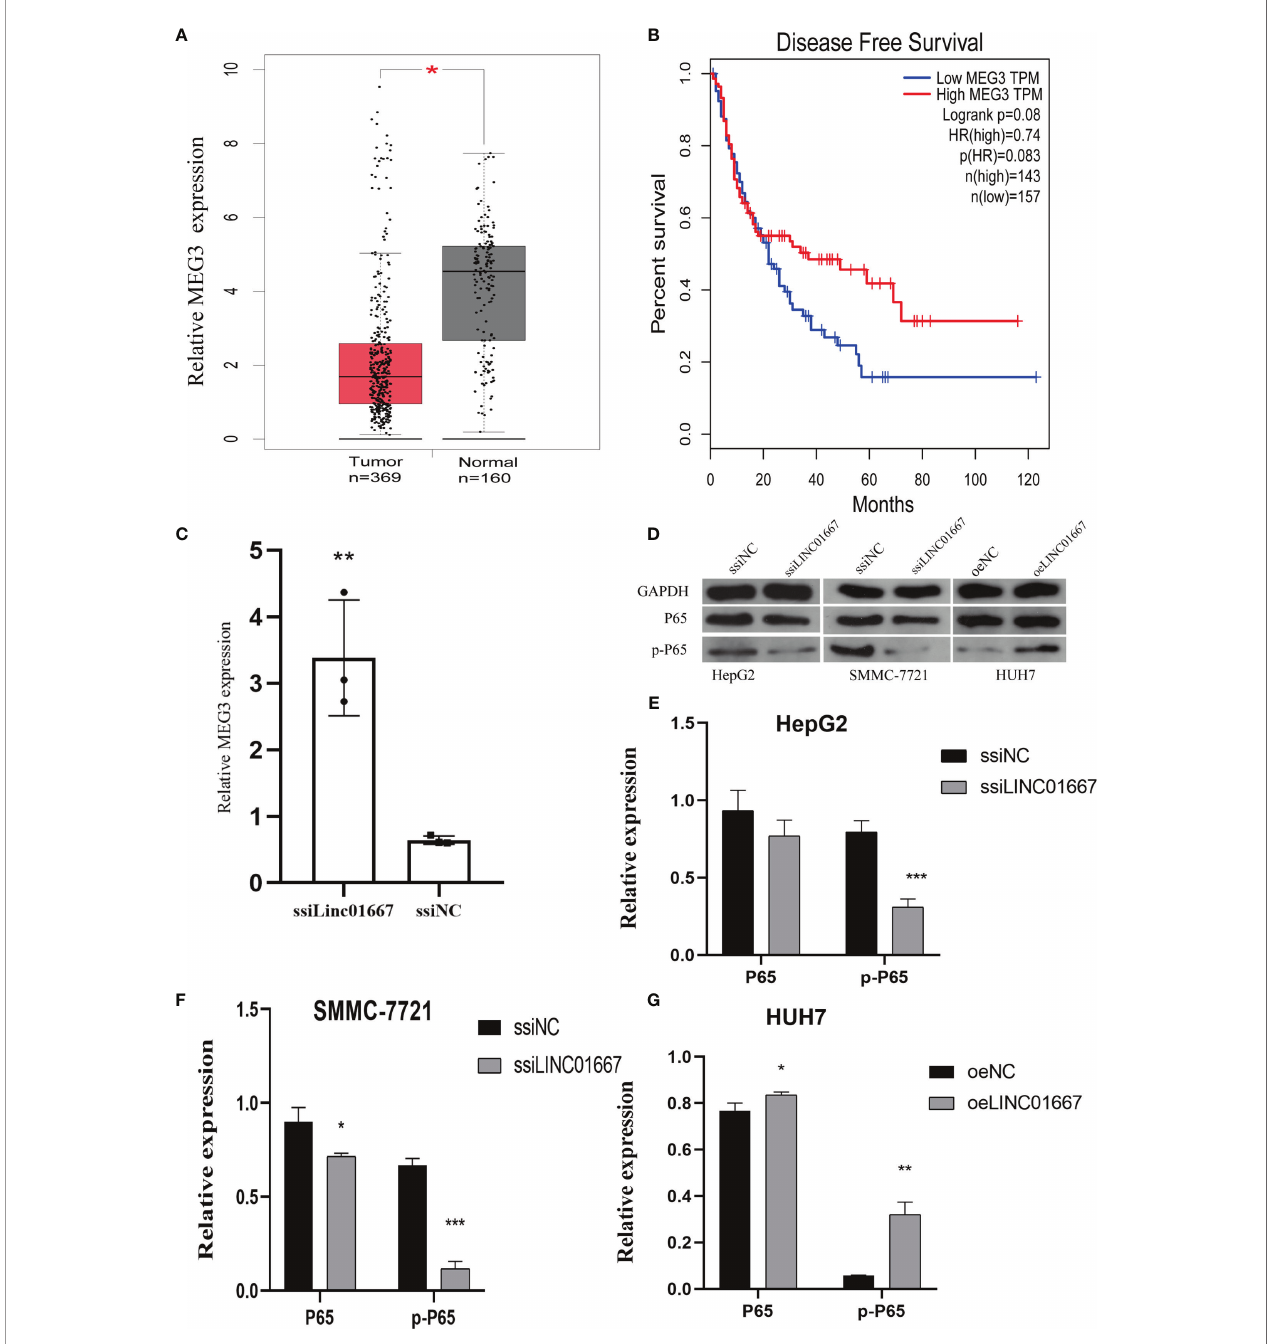
FIGURE 6 | LINC01667 has a regulatory relationship with MEG3 and NF-kB. (A) MEG3 expression levels in TCGA and GEPIA cohorts (normal = 160, tumor = 369, *P < 0.05). (B) Kaplan – Meier curves showing the DFS of patients with HCC according to high and low MEG3 expression in a TCGA cohort (n = 300). (C) Knockdown of LINC01667 increases the expression of MEG3. (D – G) LINC01667 could activate the NF-kB pathway. *P < 0.05. **P < 0.01, ***P < 0.001. oeNC represents the empty vector group, and oeLINC01667 represents the overexpression LINC01667 group, ssiNC represents the random sequence, and ssiLINC01667 represents the knockdown LINC01667